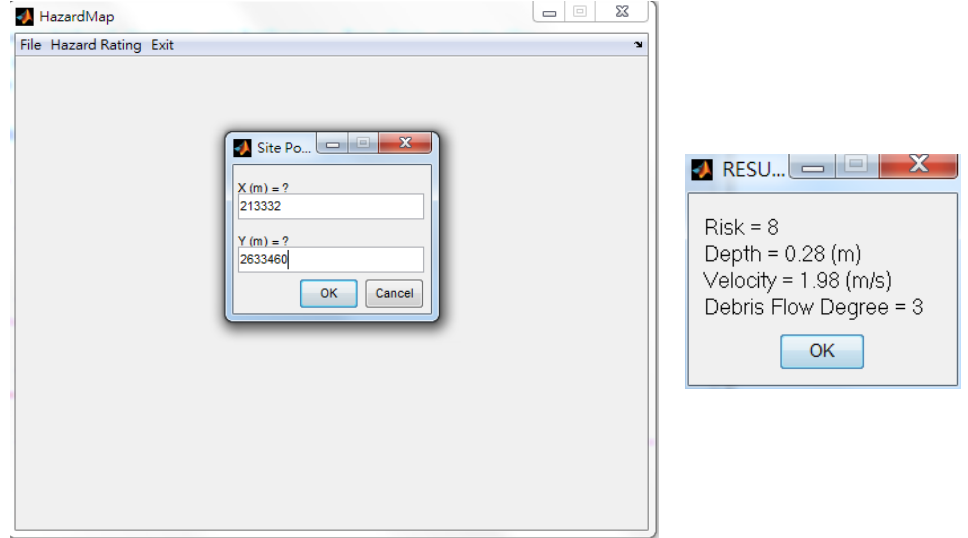
Figure 10. Calculation of environmental risk and potential debris flow grade with GIS overlay (the example of Dayuan Activity Center).